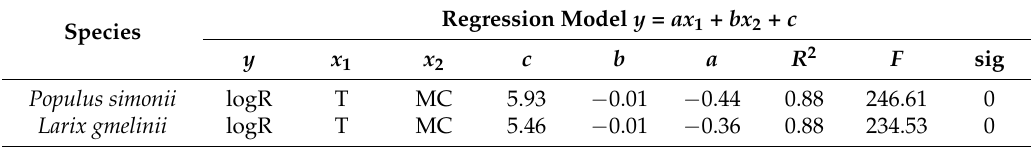
Table 3. Regression model of logR to temperature and moisture content in the decayed samples.